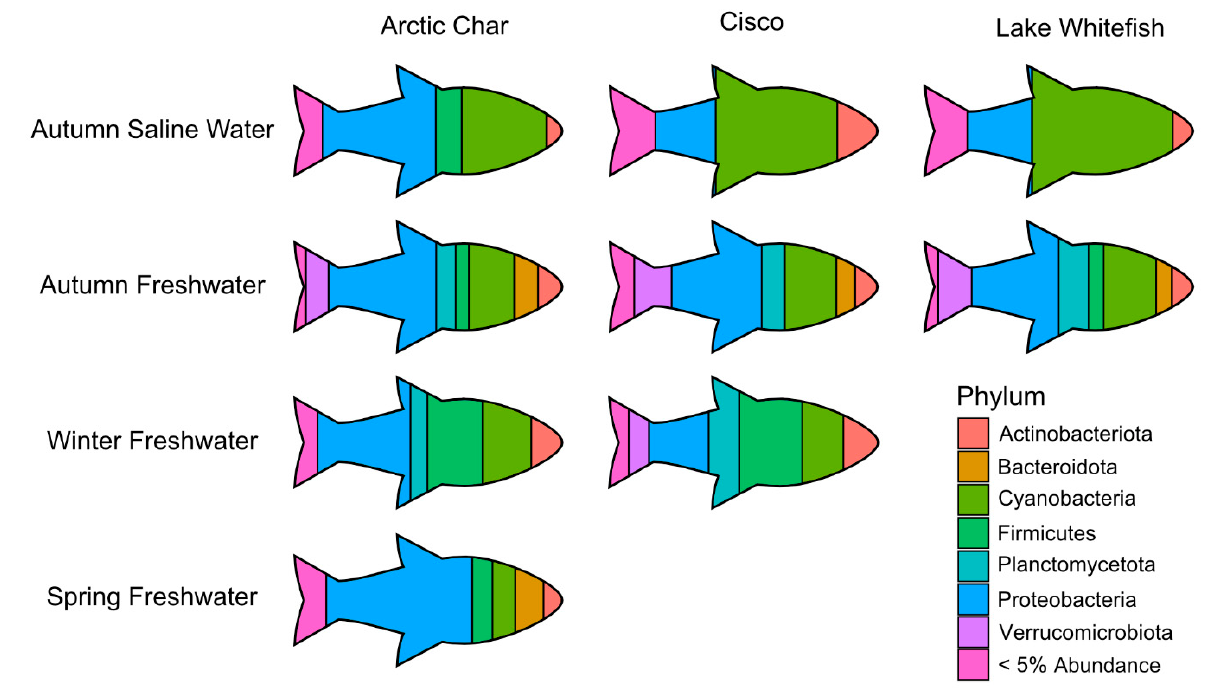
Figure 5. A pictograph showing abundant skin-associated microbiota in the high Arctic salmonids under study and across seasonal gradients. For simplicity, only the most prominent phyla are shown at their average relative abundance in Arctic char, cisco and lake whitefish. Phyla comprising < 5% average relative abundance are grouped together and only those seasonal habitats with sufficient number of caught fi sh are shown.